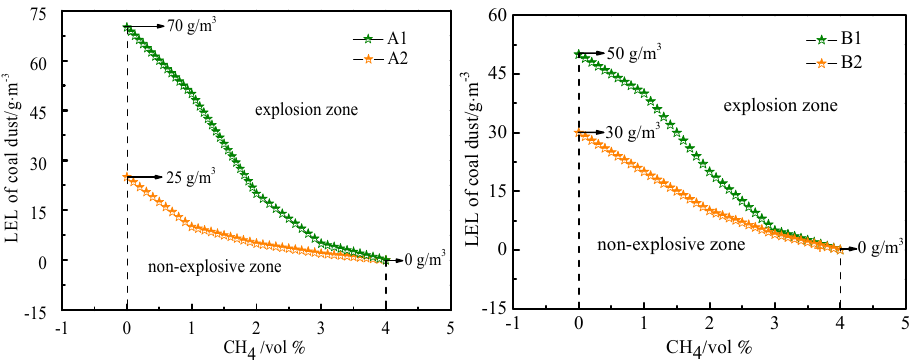
Figure 4. The minimum explosion concentration of coal dust varying with methane concentration. The effects of gas on the minimum explosion pressure of different coal dust were further analyzed. Using the decreasing amplitude ϕ of the minimum explosion concen- tration of coal dust caused by gas as the ordinate, and the gas concentration y as the abscissa, the comparison chart of the different influences of gas on the minimum explosion concentration of different coal dusts is obtained, as shown in Figure 5. It is shown that compared with B1 and B2, the minimum explosive concentration of A1 and B1 has a greater decrease amplitude under the same concentration of gas. Because the volatile content of A1 and B1 is lower than that of A2 and B2, it can be inferred that the gas has a greater impact on the minimum explosion concentration of low-volatile coal dust. This is because the lower the volatile content of the coal dust, the lower the pyrolysis combustible gas content, which leads to a higher amount of coal dust required to pyrolyze enough combustible gas to maintain the combustion. Therefore, when the same concentration of gas is added, the minimum explosive concentration of low-volatile coal dust will be lower. However, with an increase of the gas concentration, the difference of the decreasing amplitude ϕ between different coal dusts gradually decreases. It is due to that the difference of the influence of gas on the minimum explosion concentration of coal dust between different coal dusts decreases. This is because when the gas concentration gradually increases, the concentration of coal dust required for the explosion of the hybrid system gradually decreases, and the leading role of the gas